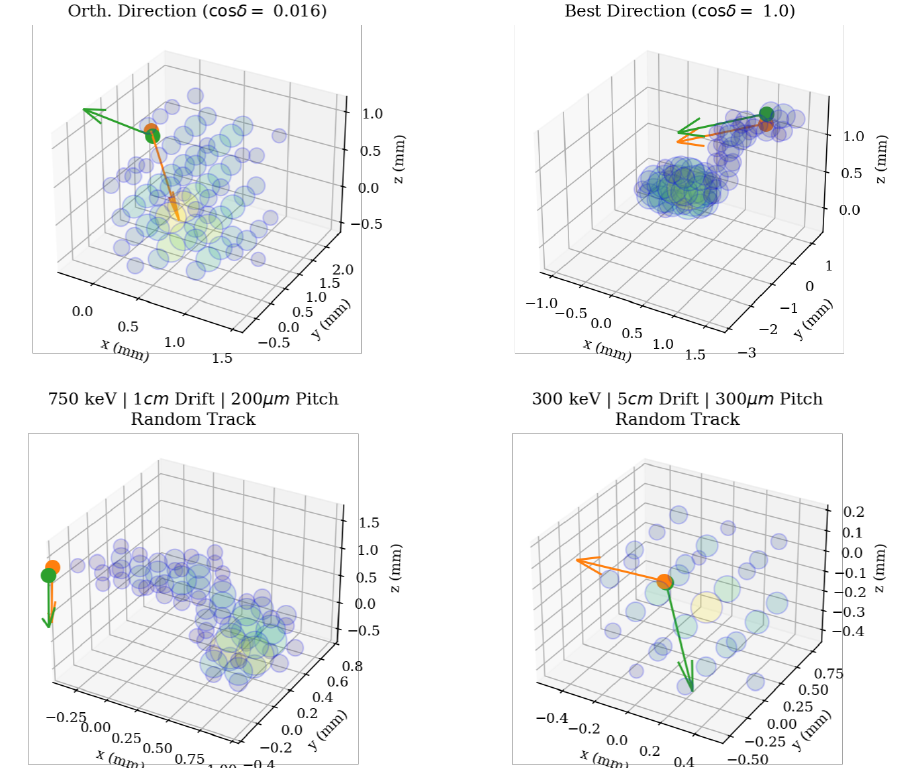
Figure 6. Selected 3D plots of the electron tracks at various energies, drift distances, and pixel pitches. The color and size of the circles indicates the amount of charge read out at a particular voxel. We denote ∆ r as the euclidean distance between the predicted and target origins, and cos δ as the cosine of the angle between the predicted and target initial direction